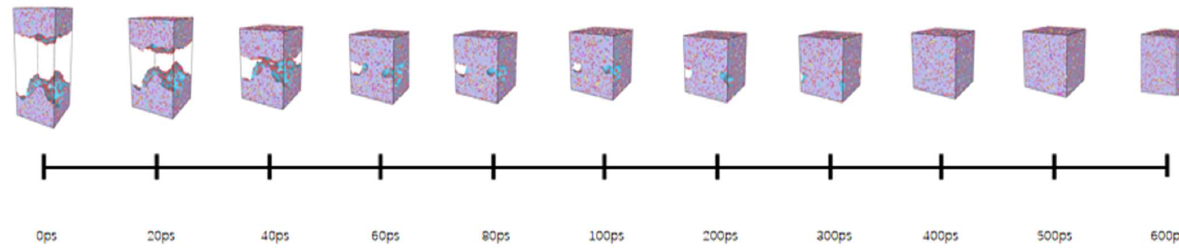
Figure 12. Variation of healing process model.